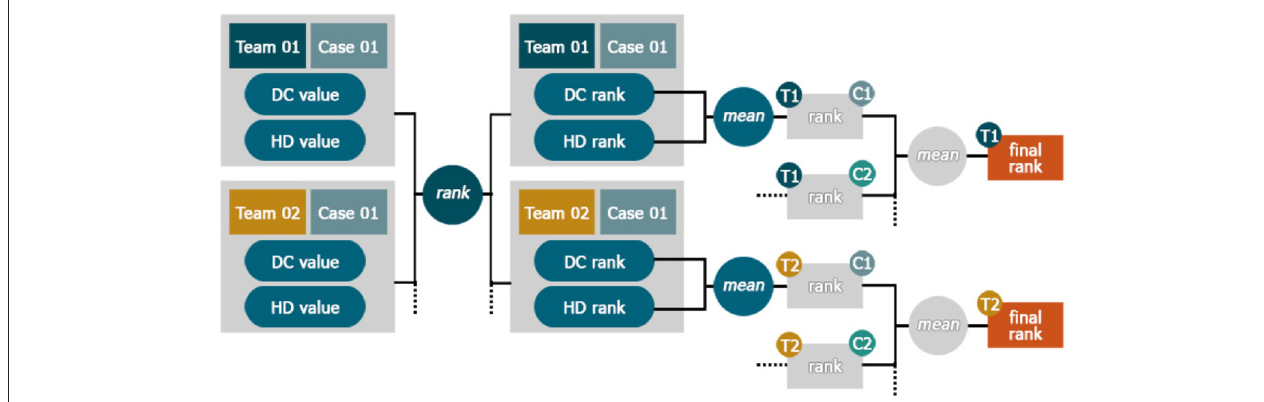
FIGURE 1 | Ranking Scheme. The teams were sorted by their different performance metrics e.g., Dice score (DC) and assigned a rank value per case. Ranks for each team were then separately averaged on a case-wise basis. The final team’s rank was then calculated as the mean of all its case-ranks.